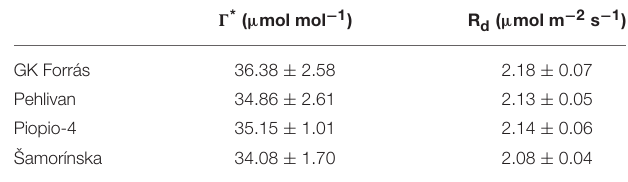
Flow of CO 2 out and into the leaf cuvette was determined for the range of C a values used with photosynthetically inactive leaves (obtained by heating) of each genotype enclosed in the chamber; the correction was used for the calculation of CO 2 fluxes (Flexas et al., 2007).